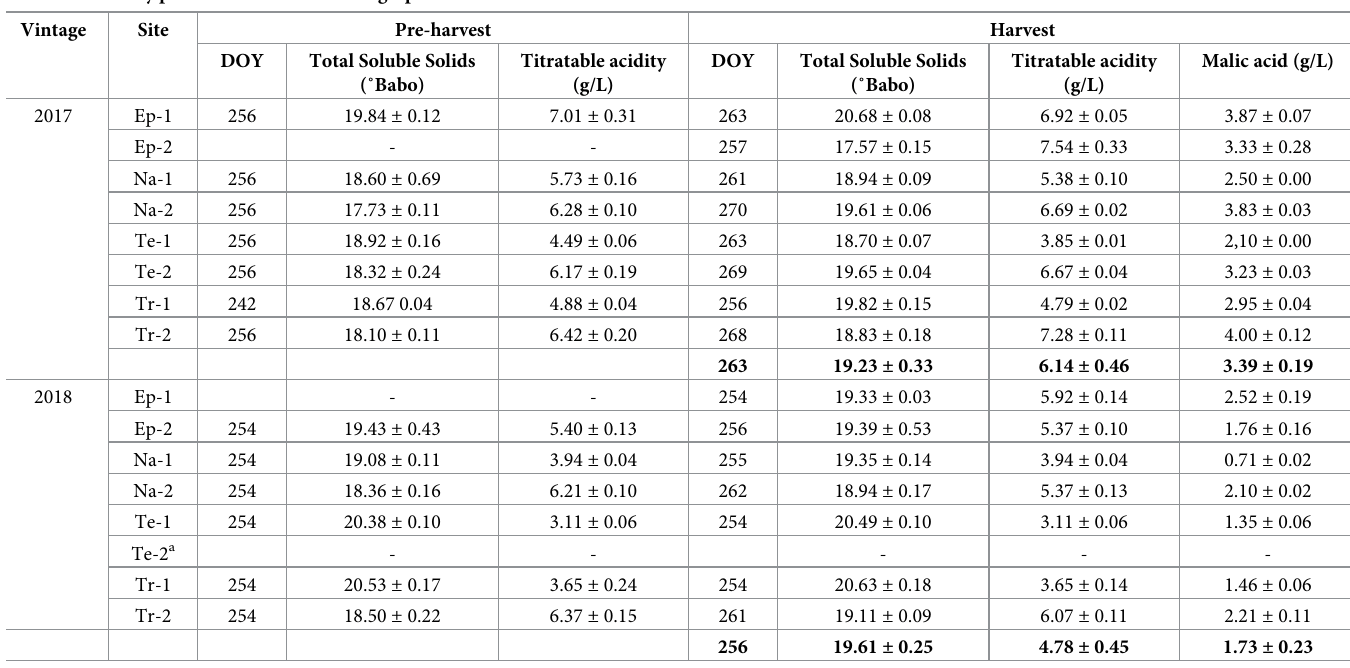
Table 1. Maturity parameters of Pinot blanc grapes.